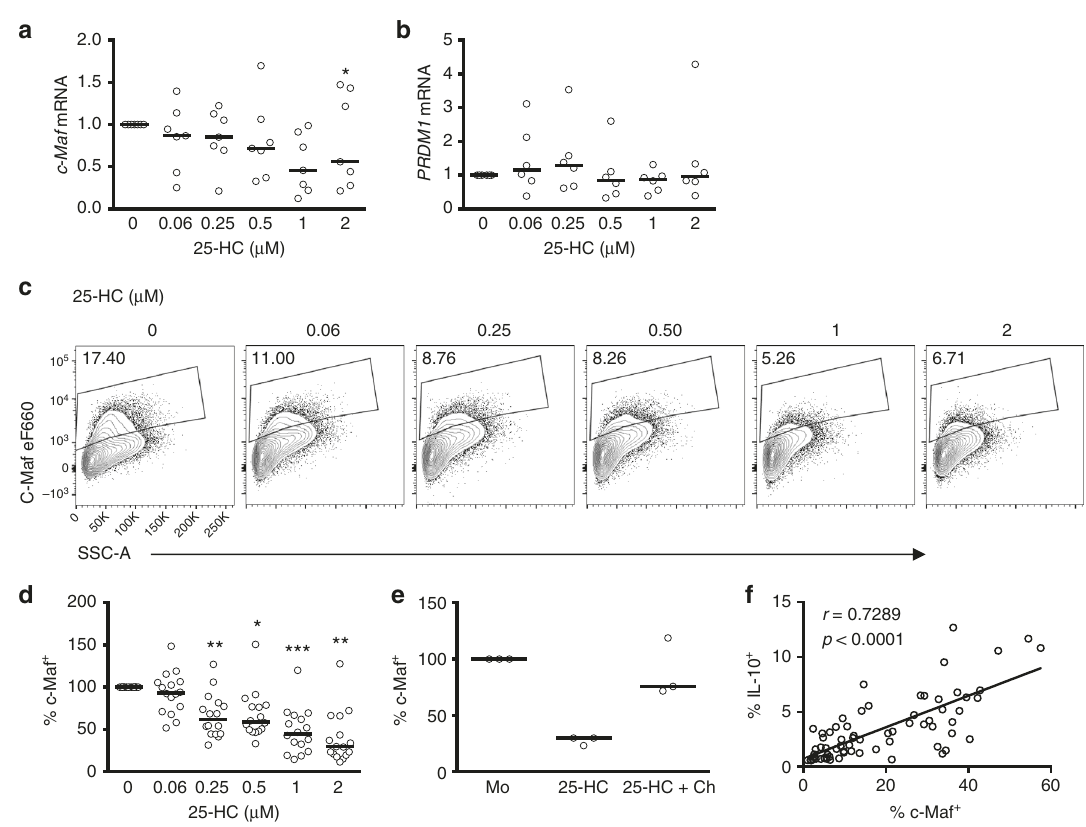
Fig. 5 Cholesterol biosynthesis pathway inhibition interferes with c-Maf expression. Puri fi ed human CD4 + T cells stimulated in vitro with plate-bound α -CD3 (2 μ gml − 1 ) + α -CD46 (5 μ gml − 1 ) and recombinant human interleukin-2 (rhIL-2) (50 Uml − 1 ) were cultured for 36 h in the presence of 25- hydroxycholesterol (25-HC). a Expression levels of MAF mRNA ( n = 7). b Expression levels of PRDM1 mRNA ( n = 6). c Representative fl ow cytometric analysis of intracellular c-Maf staining. d Normalised frequency of c-Maf + cells ( n = 16). e Normalised frequency of c-Maf + cells cultured under fully supplemented medium (M) and cholesterol (500×) (Ch) in the presence or absence of 2 μ M 25-HC ( n = 3). f Correlation between frequency of c-Maf + and IL-10 + cells, numbers denote r and p values for Spearman's correlation test. Graphs show independent donors (dots) normalised to untreated cells; bars represent median values. *<0.05 and **<0.01 denote a signi fi cant difference compared to untreated cells by Friedman test with post hoc Dunn ’ s correction ( a ) or by repeated-measures one-way analysis of variance (ANOVA) test with post hoc Dunnett ’ s correction ( d